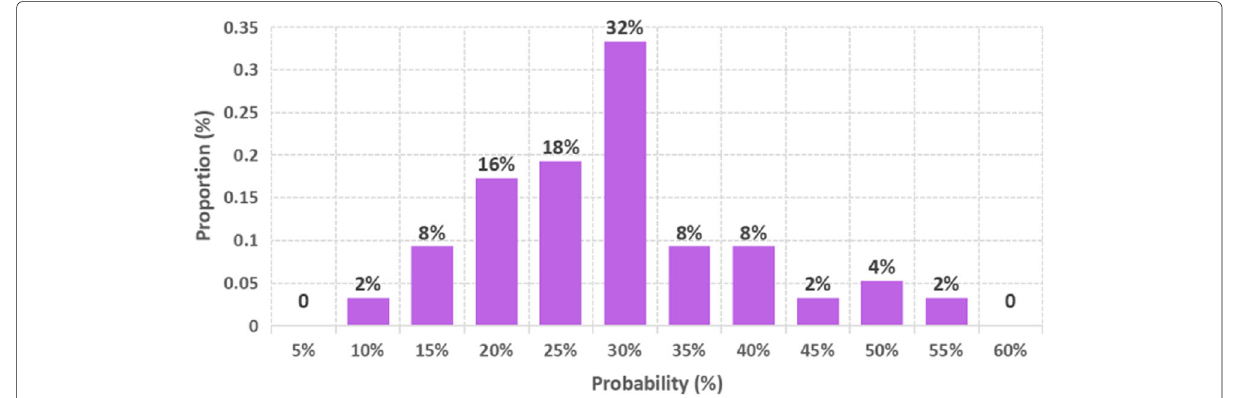
Fig. 8 Proportion distribution of the electric motorcycles